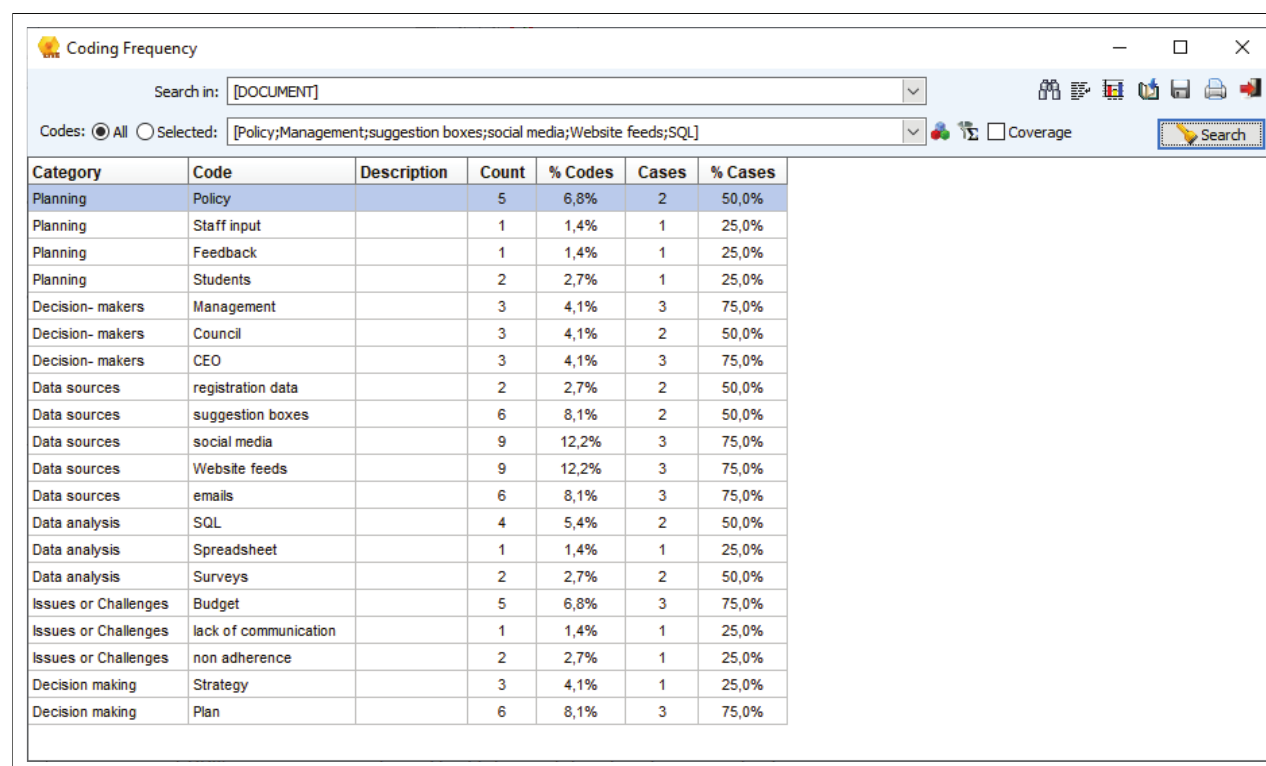
FIGURE 7: QDA Miner Lite – screenshot of the themes from